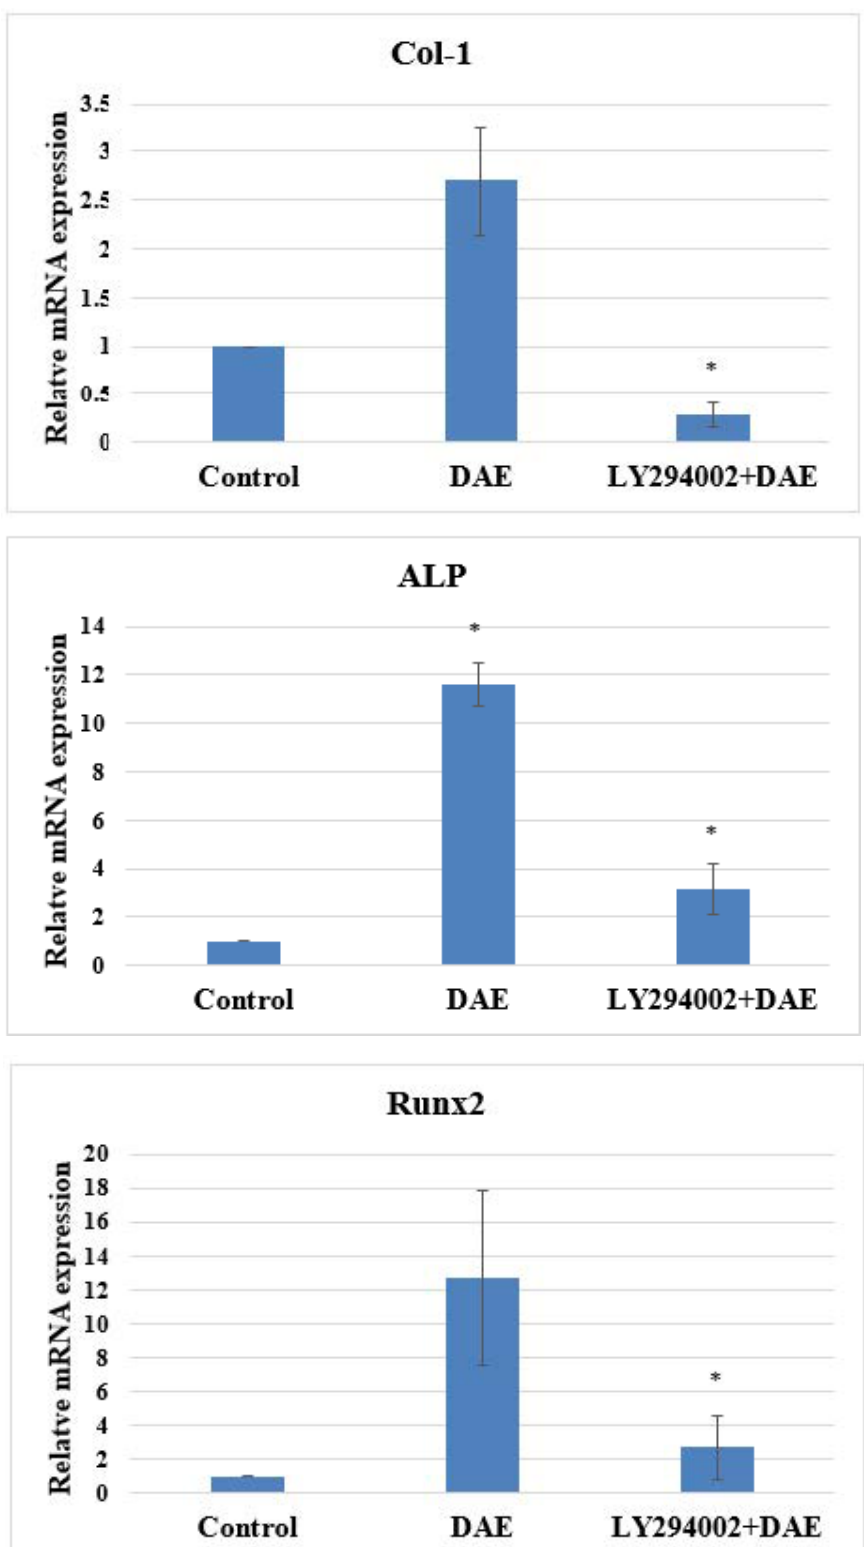
Figure 5. Quantitative RT-PCR analysis of the Col-1, ALP, and Runx2 genes after treatment of PDLSCs with PI3K inhibitor. Values are expressed as mean ± SD (n = 3), * p < 0.05 for compared with control group.